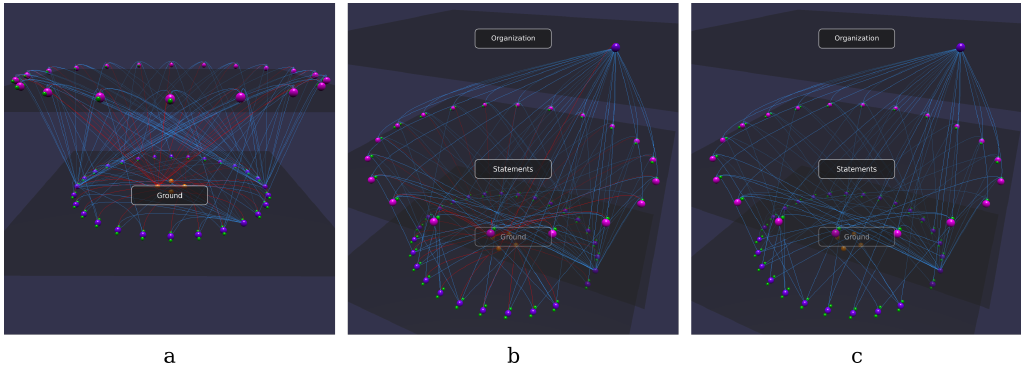
Figure 16. Use Case #3: A first semantic plane hosts instances of the class rdf:Statement ( a ). A multi-planar view with a topmost semantic plane dedicated to foaf:Organization1 shows the link among the organization and the statements ( b ). Then, unnecessary edges are hidden ( c